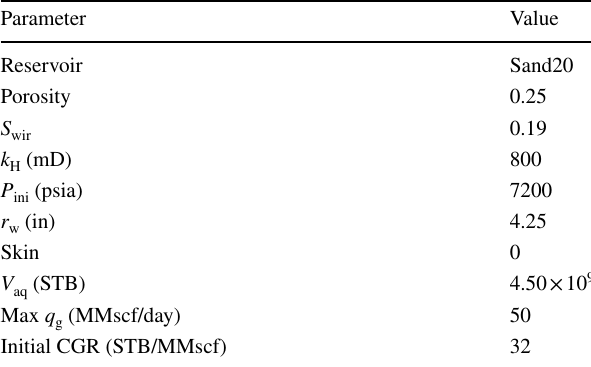
Table 4 Simulation input data for Sand20 gas-condensate reservoir Parameter Value